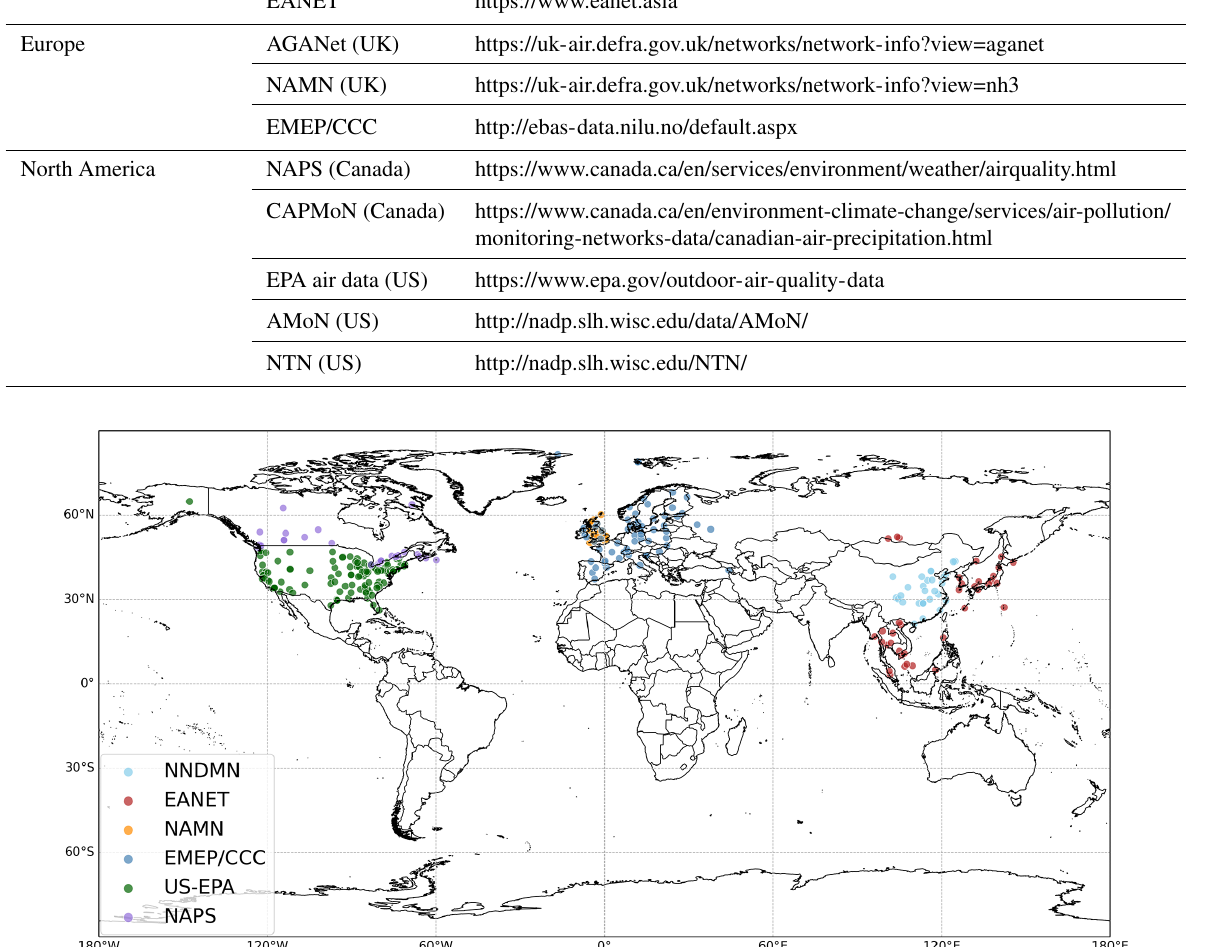
Figure 1. Locations of sites in the six networks that measured particle-phase NH 4 + in 2015.